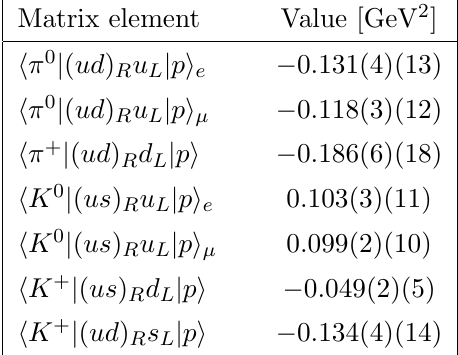
Table 1 . Hadronic matrix elements used in our analysis, which are taken from ref. [97]. The statistical and systematic uncertainties are indicated by ( : : : )( : : : ). The subscripts e and (cid:22) indicate that the matrix elements are evaluated at the corresponding lepton kinematic